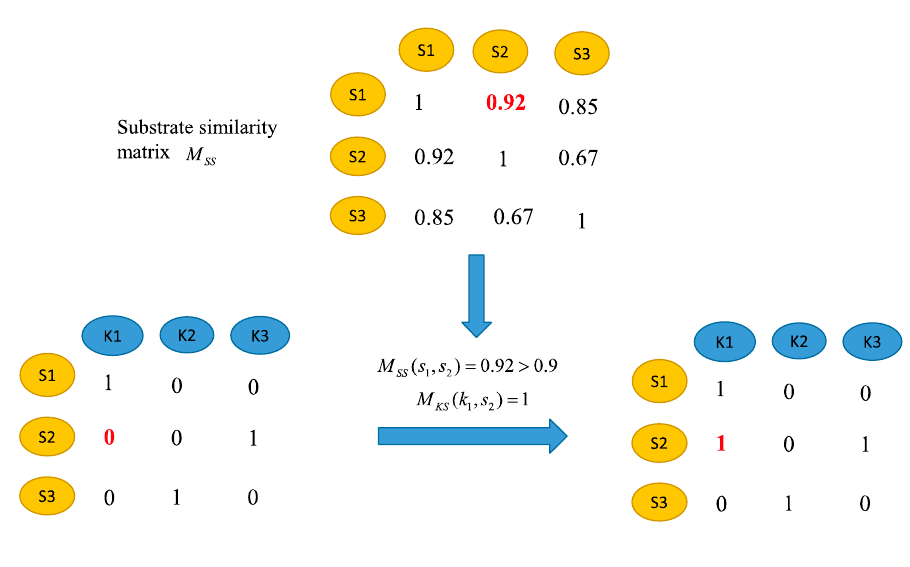
Figure 3. Adjust the kinase–substrate association network.